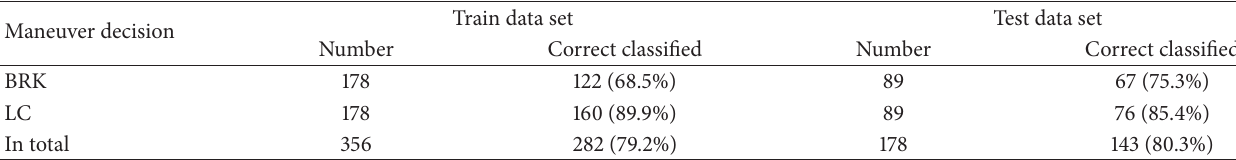
Table 5: Classification